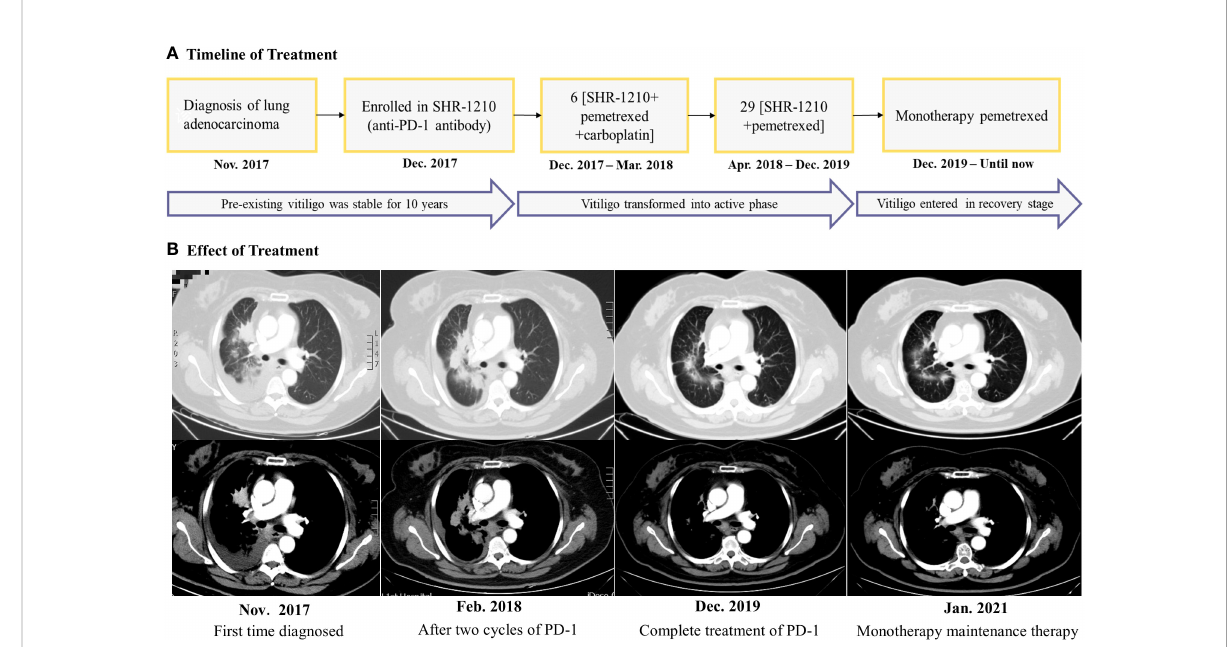
FIGURE 1 (A) Timeline for the diagnosis, treatment, and changes of the vitiligo condition. (B) Chest computed tomography scans revealed the clinical response during the treatment. The ef fi cacy evaluation was stable disease after the two cycles of ‘ SHR-1210 combined with pemetrexed and carboplatin, but as the treatment time was prolonged, the tumor density gradually decreased, suggesting that the tumor has been effectively